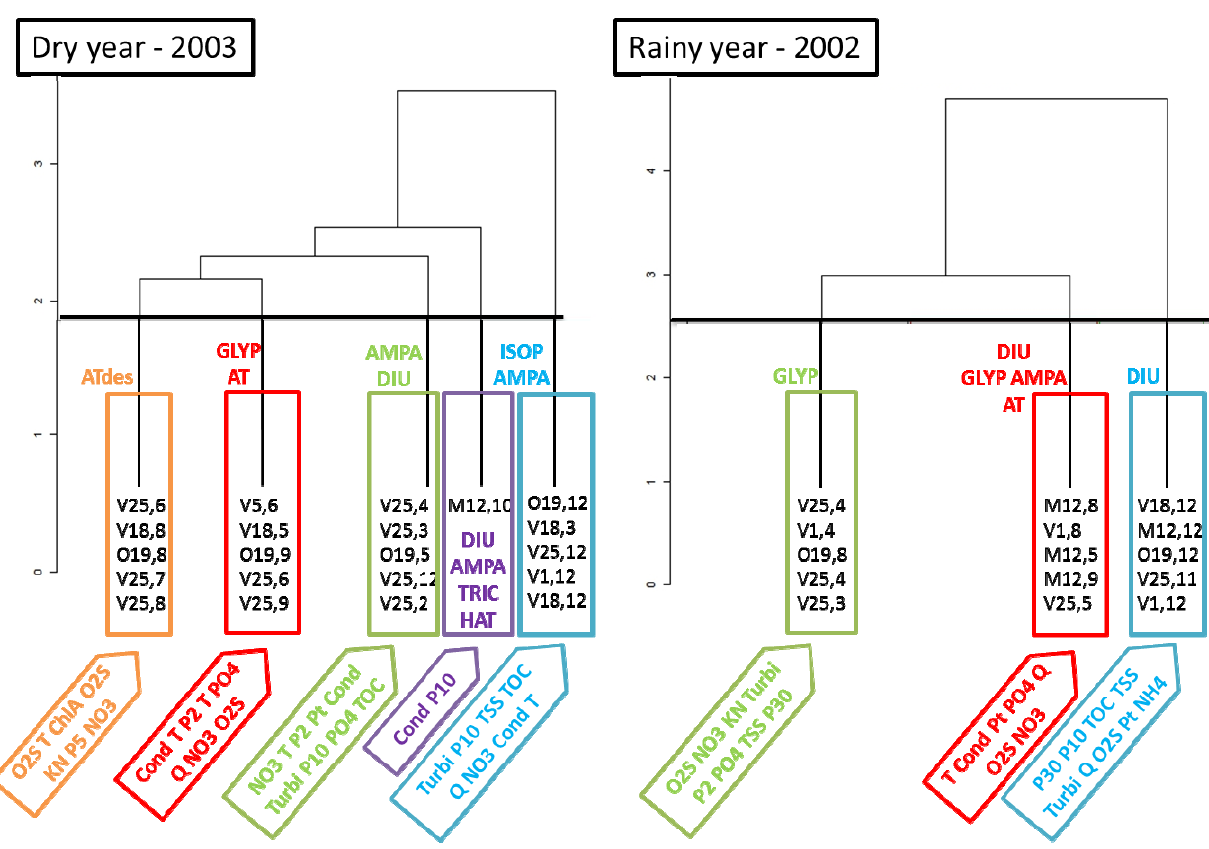
Figure 8. HCPC results on dry and rainy